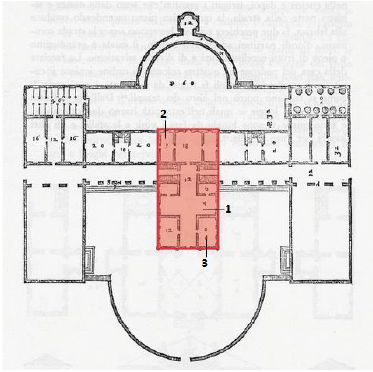
Figure 1. Villa Barbaro. In red, the rooms open to the public.